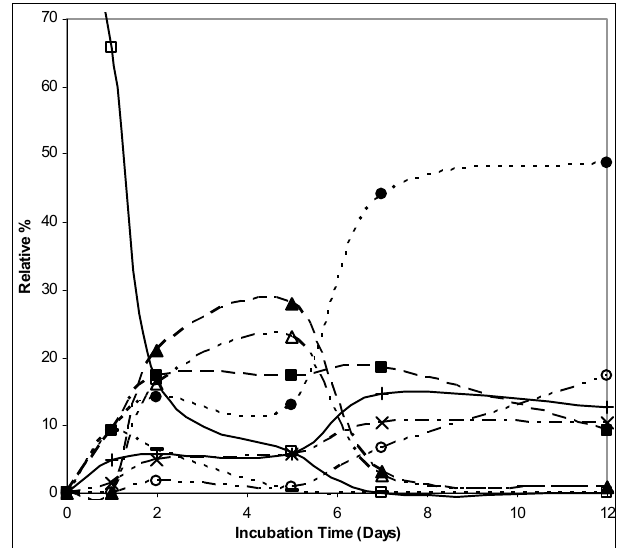
Figure 1. The relative abundance (in %) of (1 S )-2-carene and its